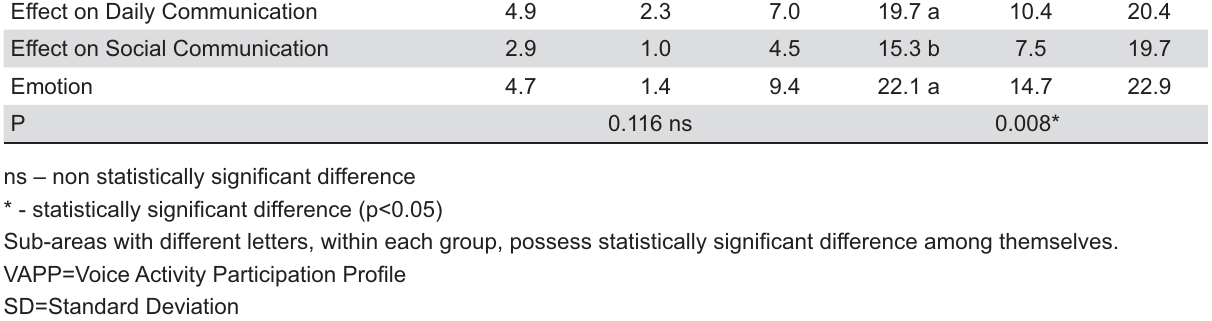
Table 5- (cid:10)/(cid:6)’(cid:16)(cid:14)(cid:15)(cid:7)(cid:21)(cid:6)(cid:17)(cid:10)"(cid:9)(cid:11)$(cid:9)(cid:9)(cid:17)(cid:10)K(cid:7)’(cid:7)(cid:11)(cid:14)(cid:11)(cid:7)(cid:6)(cid:17)(cid:10)(cid:14)(cid:17)(cid:23)(cid:10)N(cid:9)(cid:21)(cid:11)(cid:15)(cid:7)(cid:8)(cid:11)(cid:7)(cid:6)(cid:17)(cid:10)(cid:6)(cid:24)(cid:10)(cid:2)(cid:6)(cid:7)(cid:8)(cid:9)(cid:10)(cid:3)(cid:11)(cid:7)(cid:12)(cid:7)(cid:11)(cid:13)(cid:10)(cid:4)(cid:14)(cid:15)(cid:11)(cid:7)(cid:8)(cid:7)(cid:16)(cid:14)(cid:11)(cid:7)(cid:6)(cid:17)(cid:10)(cid:4)(cid:15)(cid:6)(cid:18)(cid:19)(cid:9)(cid:10)(cid:25)(cid:2)(cid:3)(cid:4)(cid:4)(cid:30)(cid:10)(cid:24)(cid:6)(cid:15)(cid:10);>(cid:10)(cid:25)(cid:15)(cid:9)(cid:16)(cid:6)(cid:15)(cid:11)(cid:9)(cid:23)(cid:10)(cid:17)(cid:6)(cid:10) vocal alteration) and GII (reported vocal